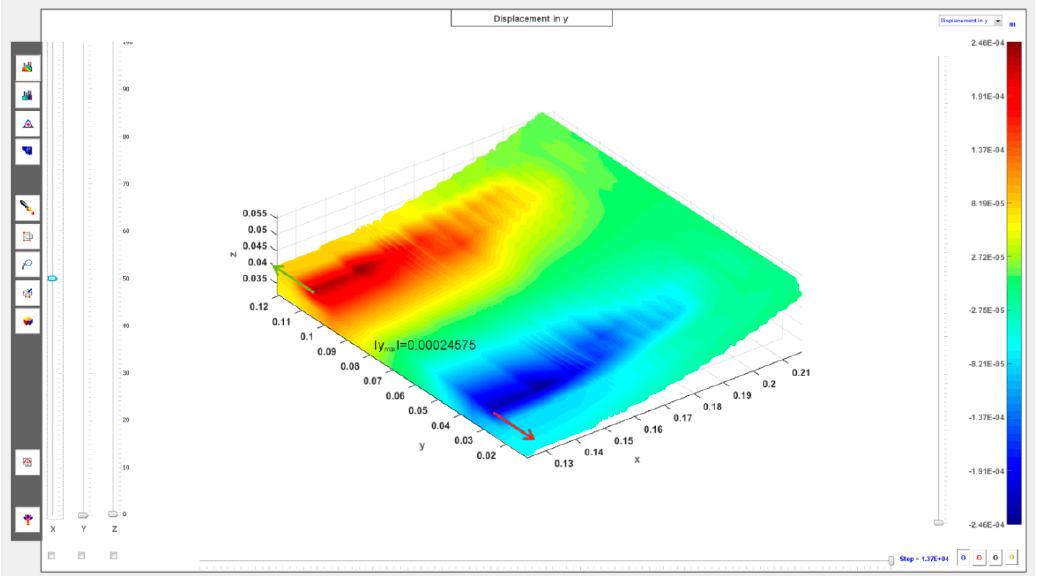
Figure A11. Displacements (in meters, middle section) in sand layer in parallel y direction to roller axis: h = 1.0 mm, p opt =2.6 bar ( N = 1300 N).